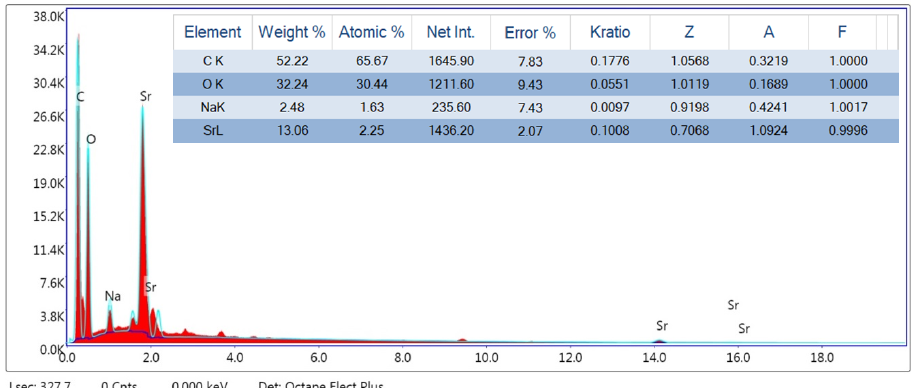
Figure 4. Energy Dispersive Spectroscopy of chitosan-SrO nanocomposites (10 wt.%).